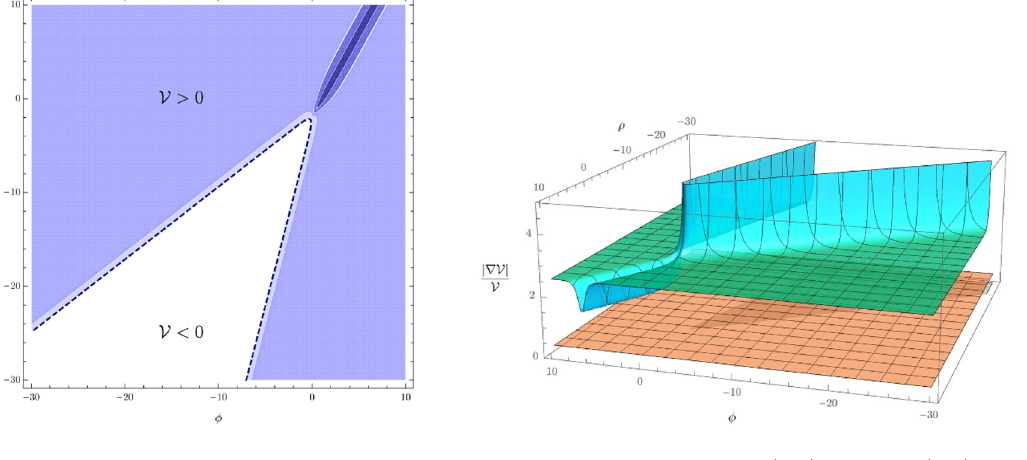
Figure 5 . On the left, in blue, the four regions of (cid:12)eld space where 1 : 5 (cid:20) jrVj in eq. (2.15). Lighter colors correspond to greater values of jrVj